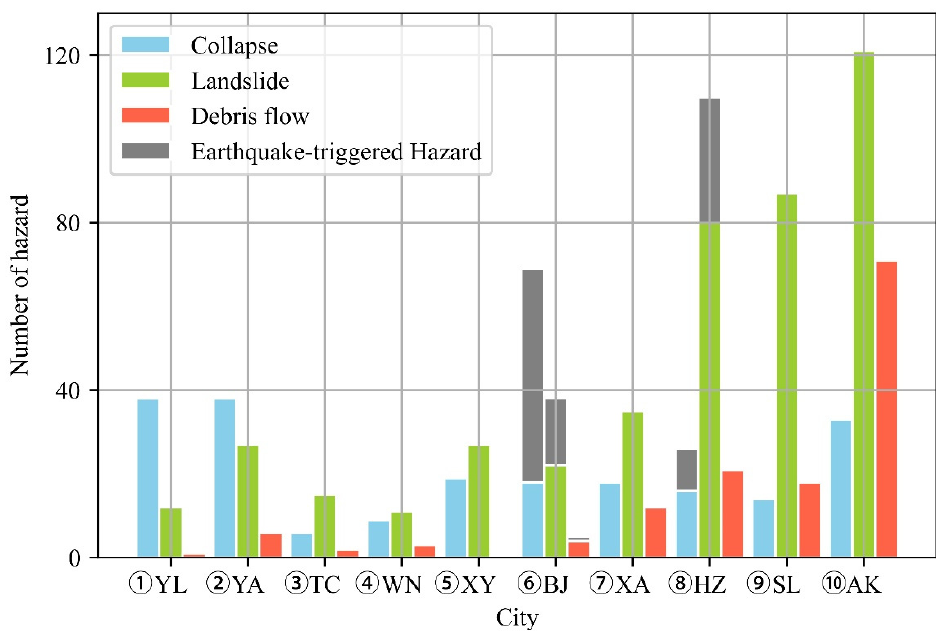
Figure 3. The frequency of geological hazards within each city region in Shaanxi province (the abbreviations of x coordinate referred to the title of Figure 1).